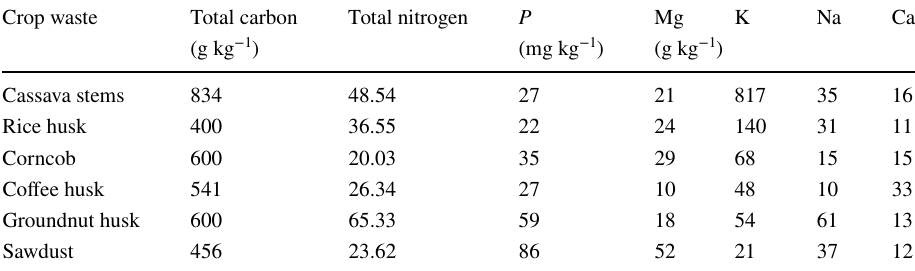
Crop waste Total